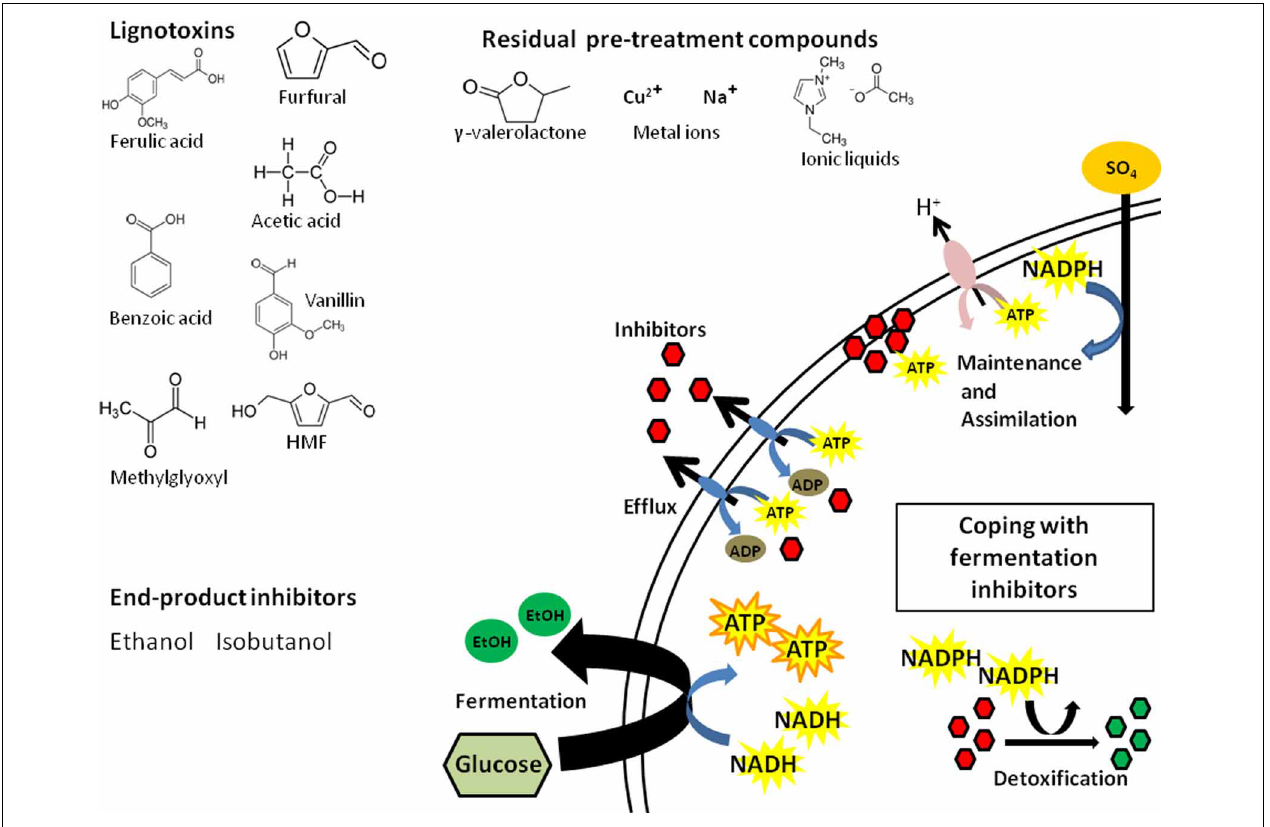
FIGURE 1 | Inhibitor classes and the cellular energy consequences of LCH inhibitors. Presented are examples from three main classes of inhibitors and the ways cells can cope with these: efflux via pumps, detoxification via enzymes, and repair of the damage caused by the